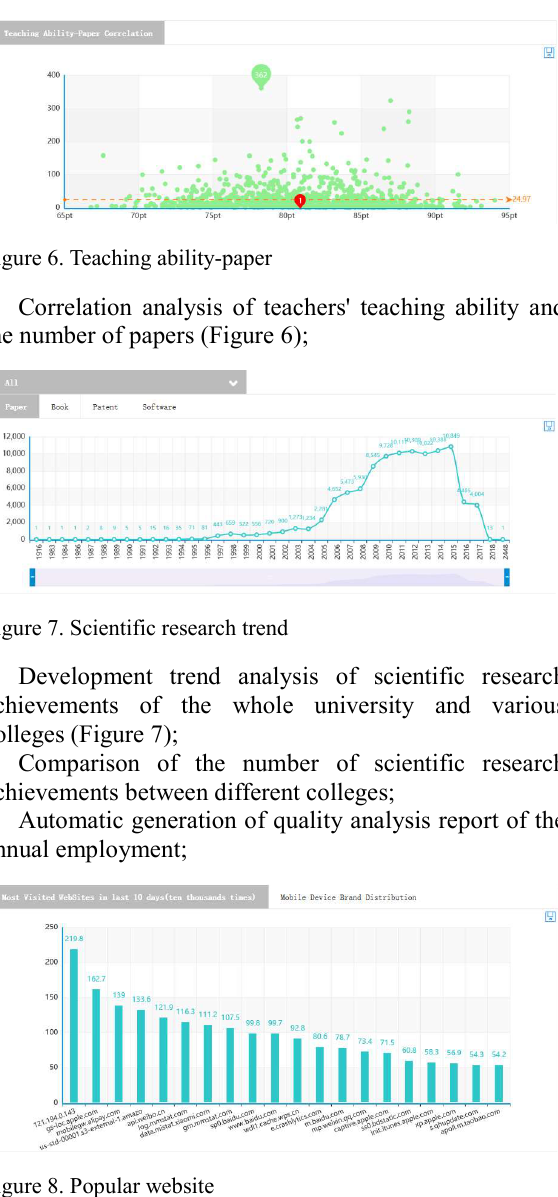
Figure 5. Project-paper projects and papers (Figure 5);